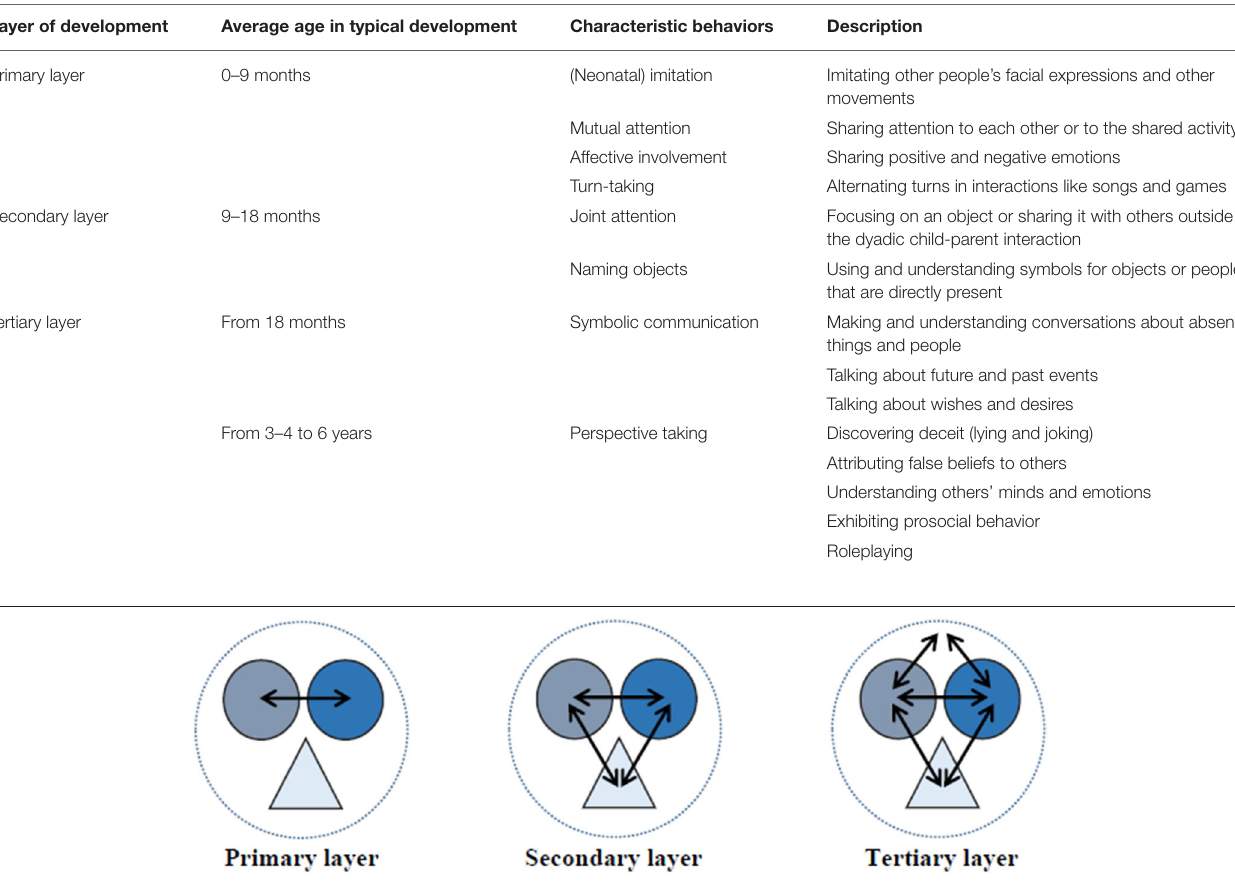
FIGURE 1 | Graphic display of the three layers of intersubjective communication development: Primary layer: interactions between child and caregiver; Secondary layer: interactions between child, caregiver, and objects; Tertiary layer: interactions between child, caregiver and their